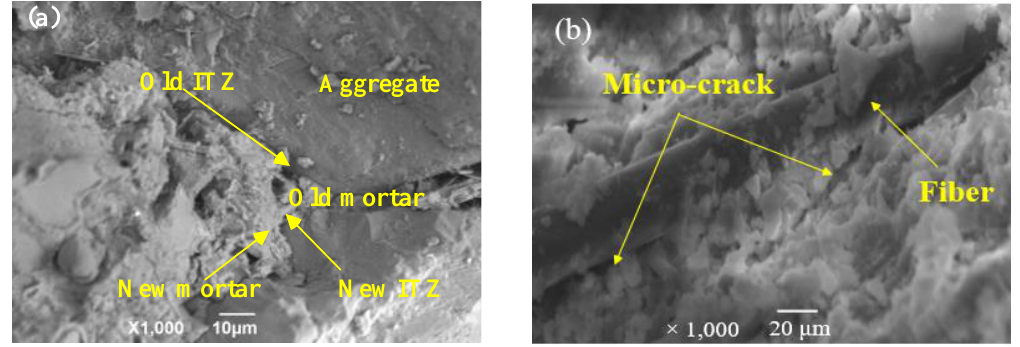
Figure 6. Interface transition zones (ITZs) in RAC: ( a ) ITZ between aggregate and cement mortar and ( b ) ITZ between fiber and cement